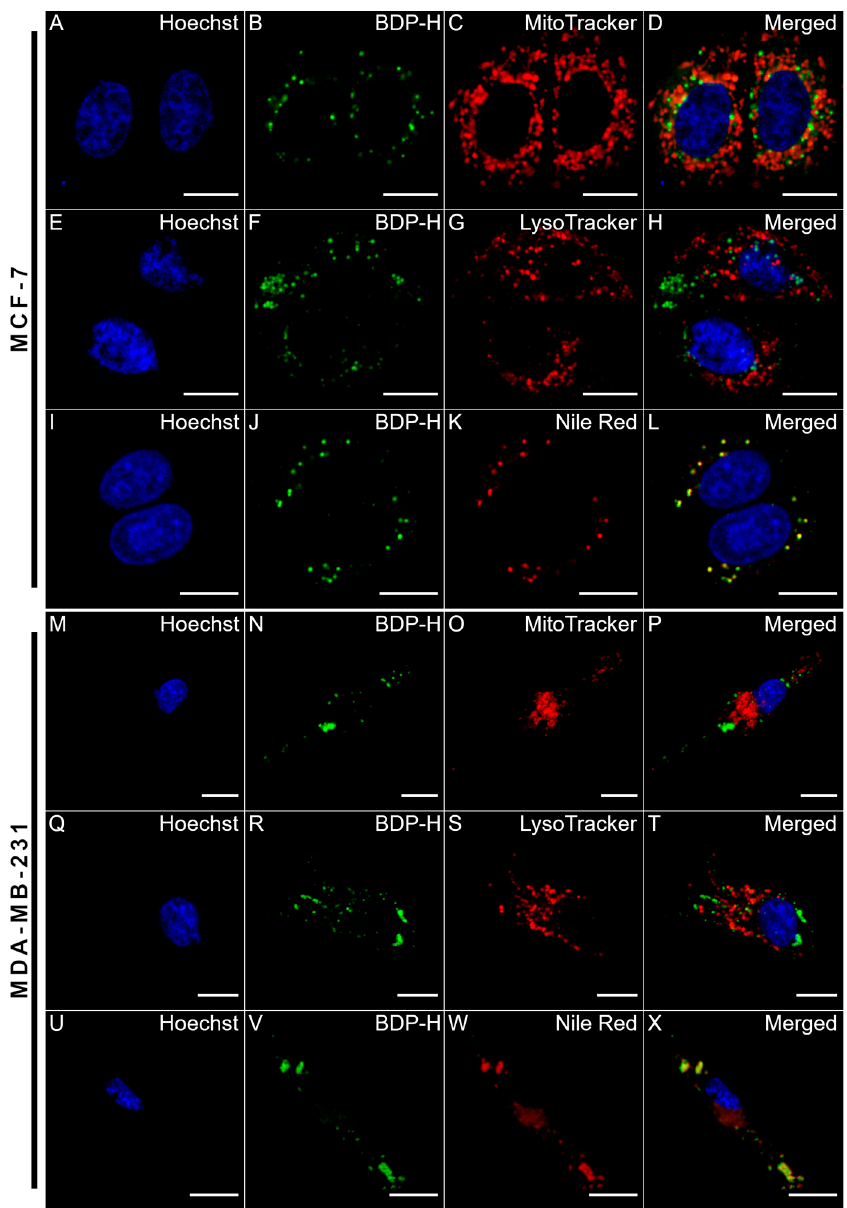
Figure 5. Confocal images of live human breast cancer cells treated with 37.5 µM Hoechst nuclei stain ( λ ex = 410 ± 5 nm) ( A , E , I , M , Q , U ), 9 µM BDP-H ( λ ex = 480±5 nm) ( B , F , J , N , R , V ) and red-emitting commercial organelle probes: 200 nM MitoTracker Red FM, 75 nM LysoTracker Deep Red or 314 nM Nile Red ( λ ex = 560 ± 5 nm) ( C , G , K , O , S , W ). ( D , H , L , P , T , X ) merged images of Hoechst, BDP-H and one of the three red-emitting commercial probes. Scale bars: 15 µ m. Results from colocalization analysis are shown in Supplementary Materials Figure S6.